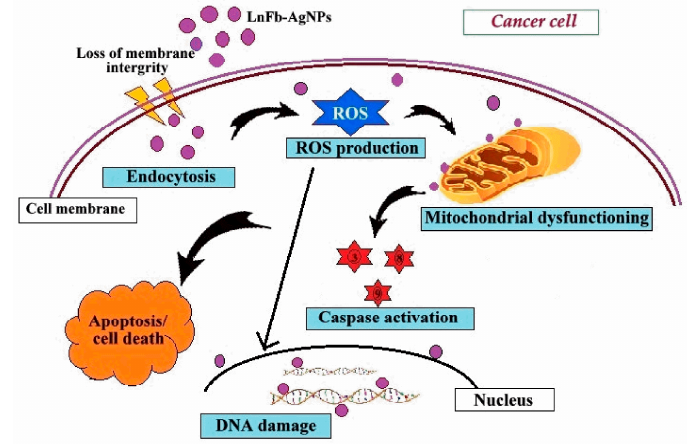
Figure 13. Diagrammatic representation of possible model mechanism of anticancer activity for biosynthesized LnFb-AgNPs from L. nepetifolia flower bud extract.